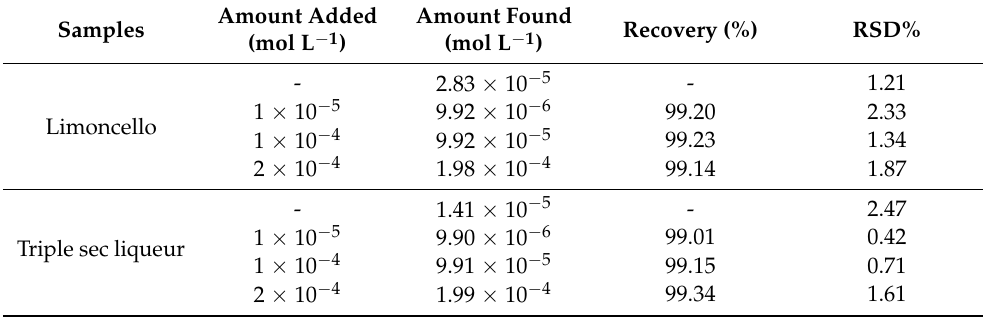
Table 5. The effect of coexisting species on the detection of 1 × 10 − 4 R-limonene (n = 5) using the TPP/AuNPs-S-Gr